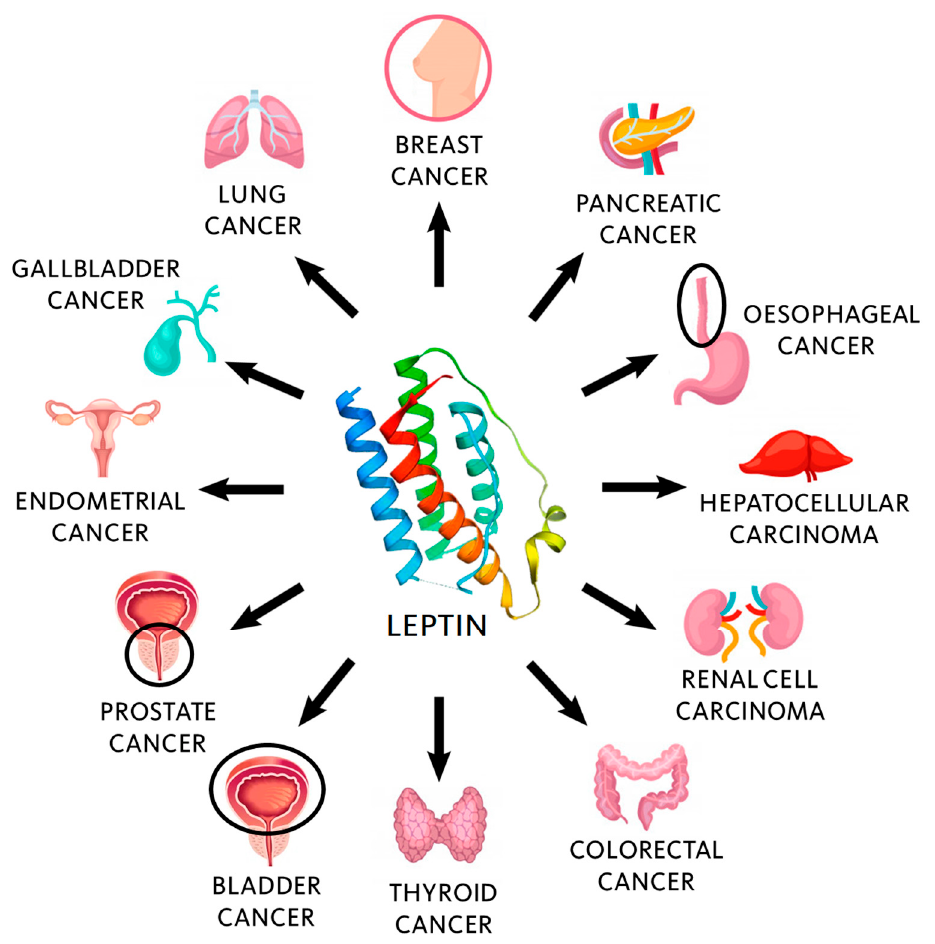
Figure 1. Leptin has been associated with many different types of